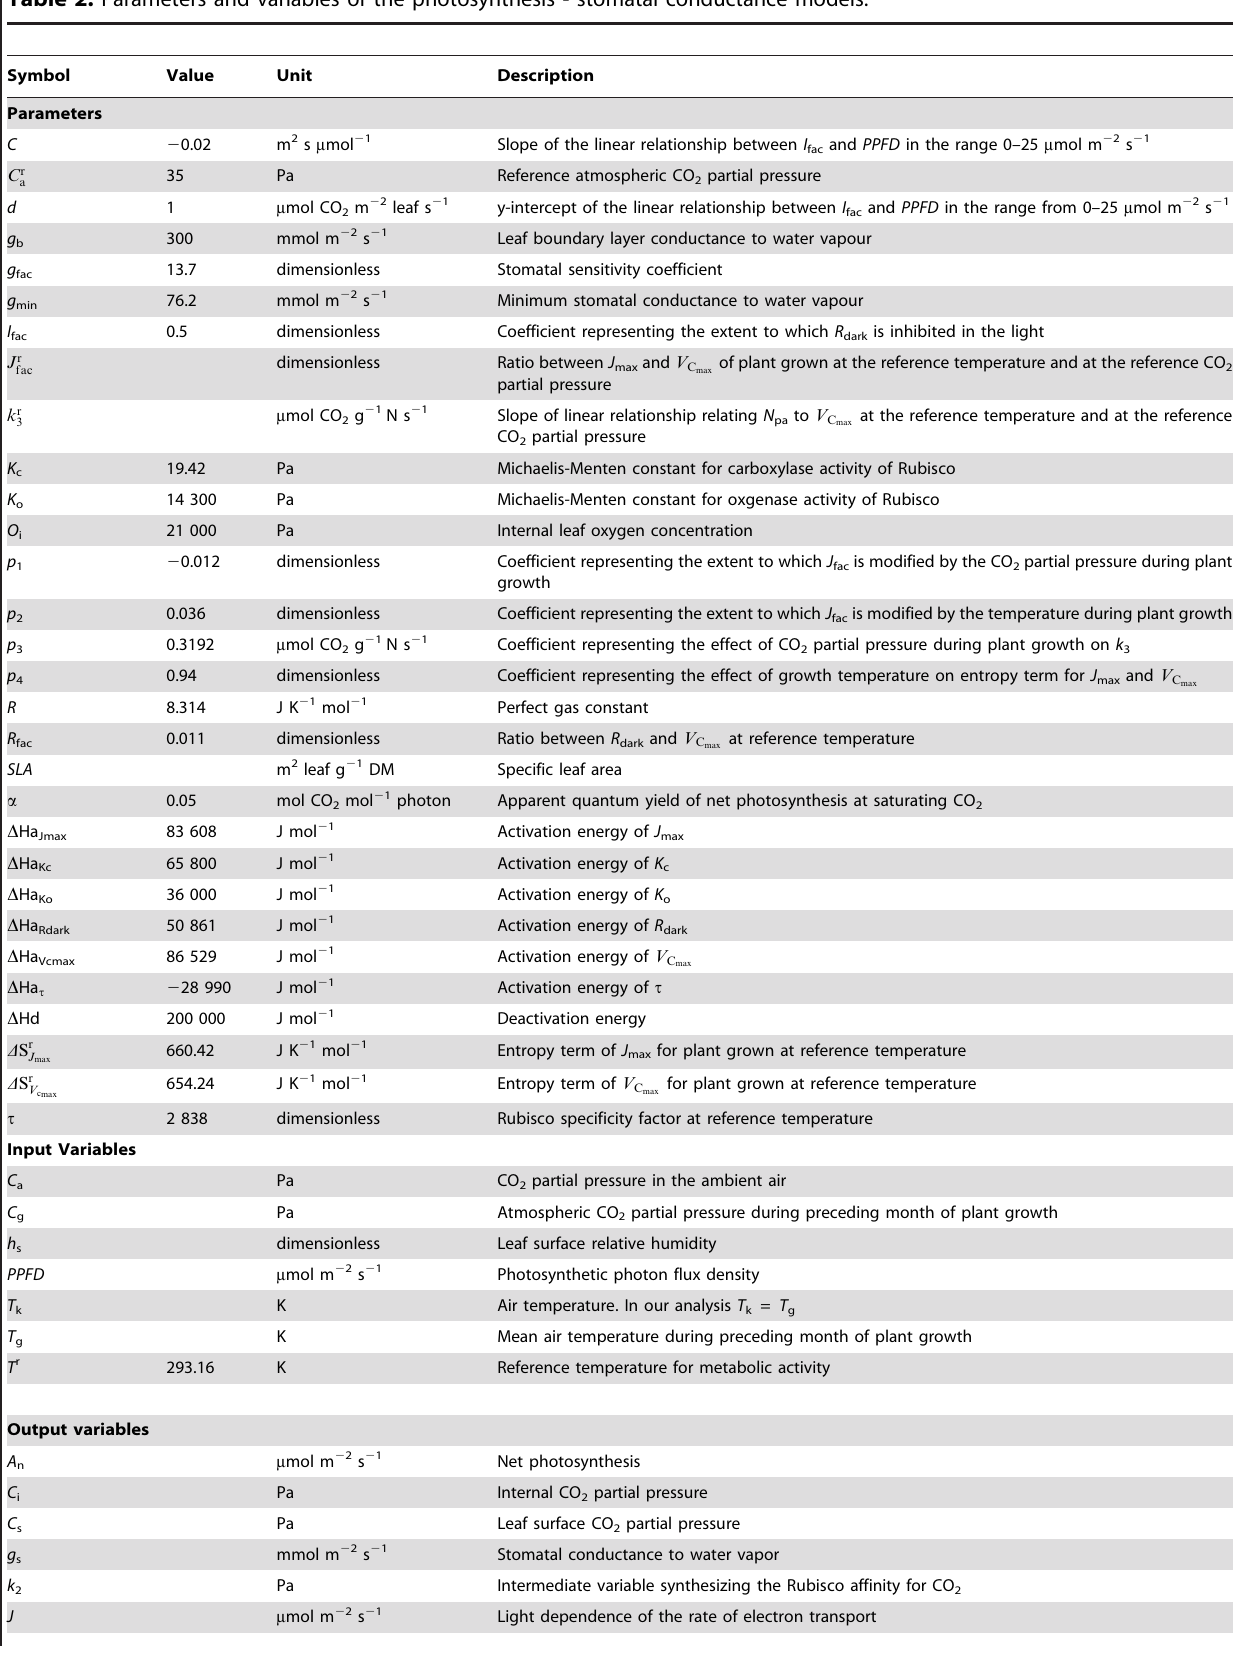
Table 2. Parameters and variables of the photosynthesis - stomatal conductance models.